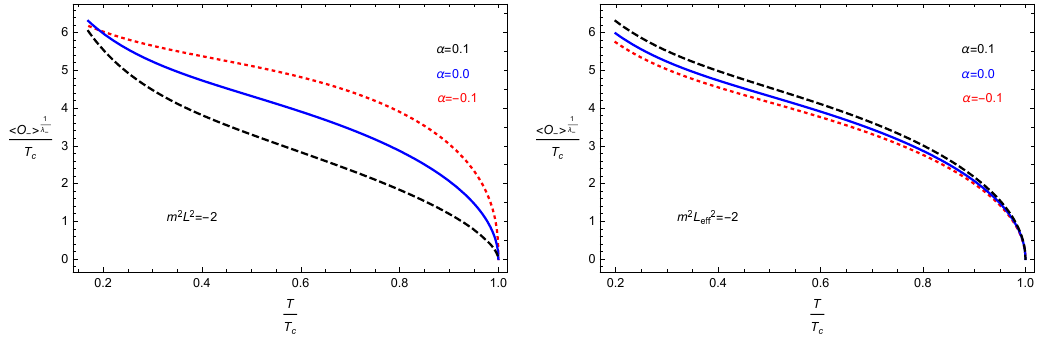
Figure 3 . The condensates of the scalar operator O − as a function of temperature for the fixed masses of the scalar field m 2 L 2 = − 2 (left) and m 2 L 2 = − 2 (right) with different Gauss-Bonnet eff parameters, i.e., α = − 0 . 1 (red and dashed), 0 . 0 (blue) and 0 . 1 (black and dashed),